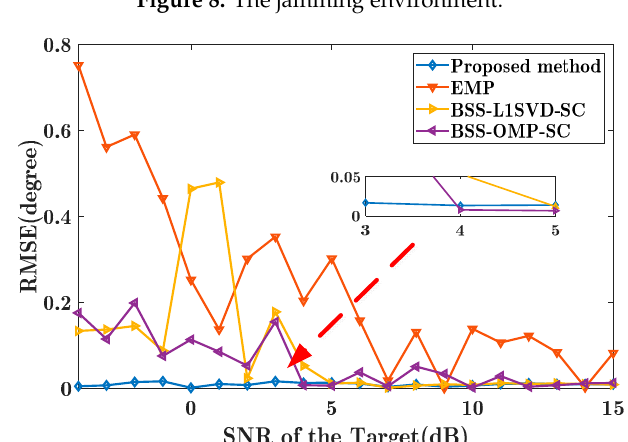
Figure 8. The jamming environment.